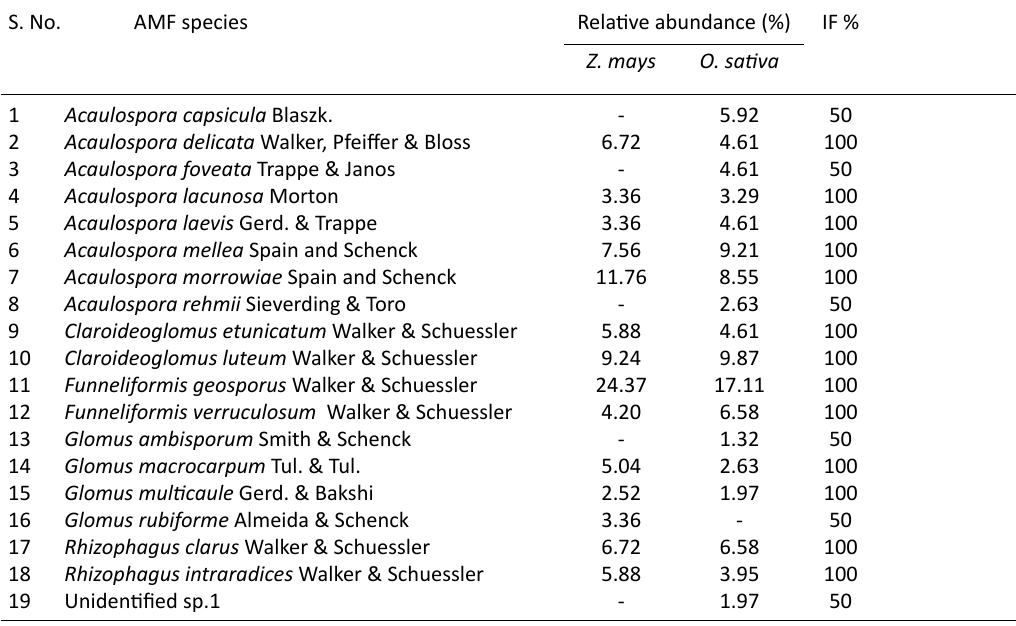
Table 3. AMF species isolated from trap cultures (15 years abandoned site derived inoculum) with their relative abundance and isolation frequency (IF) using Z. may s and O. sativa as trap plants S. No.